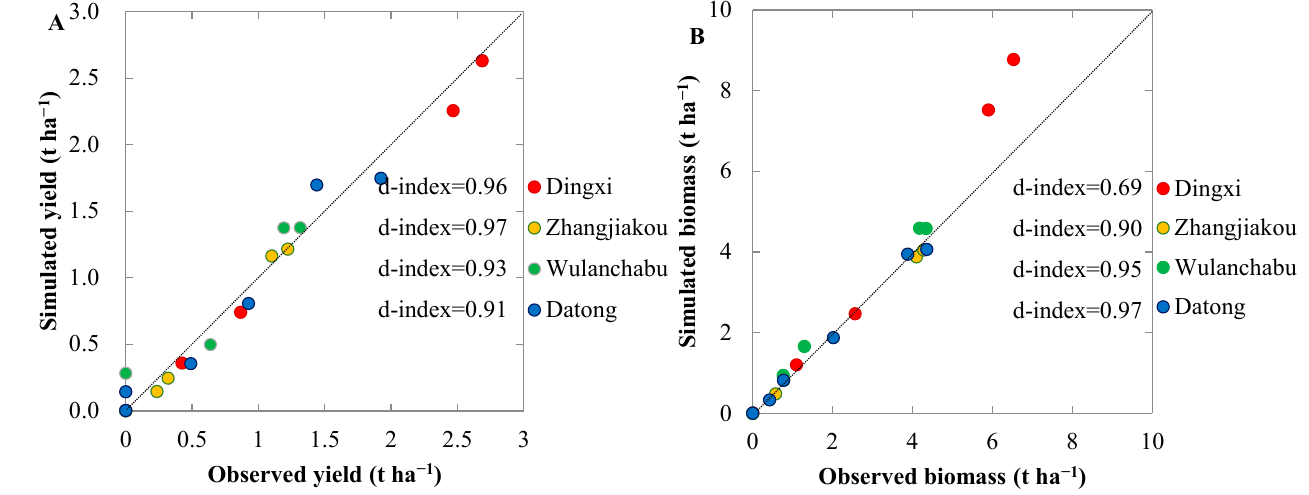
Figure 7. A comparison between simulated and observed yield ( A ) and biomass ( B ) for the four experimental sites.